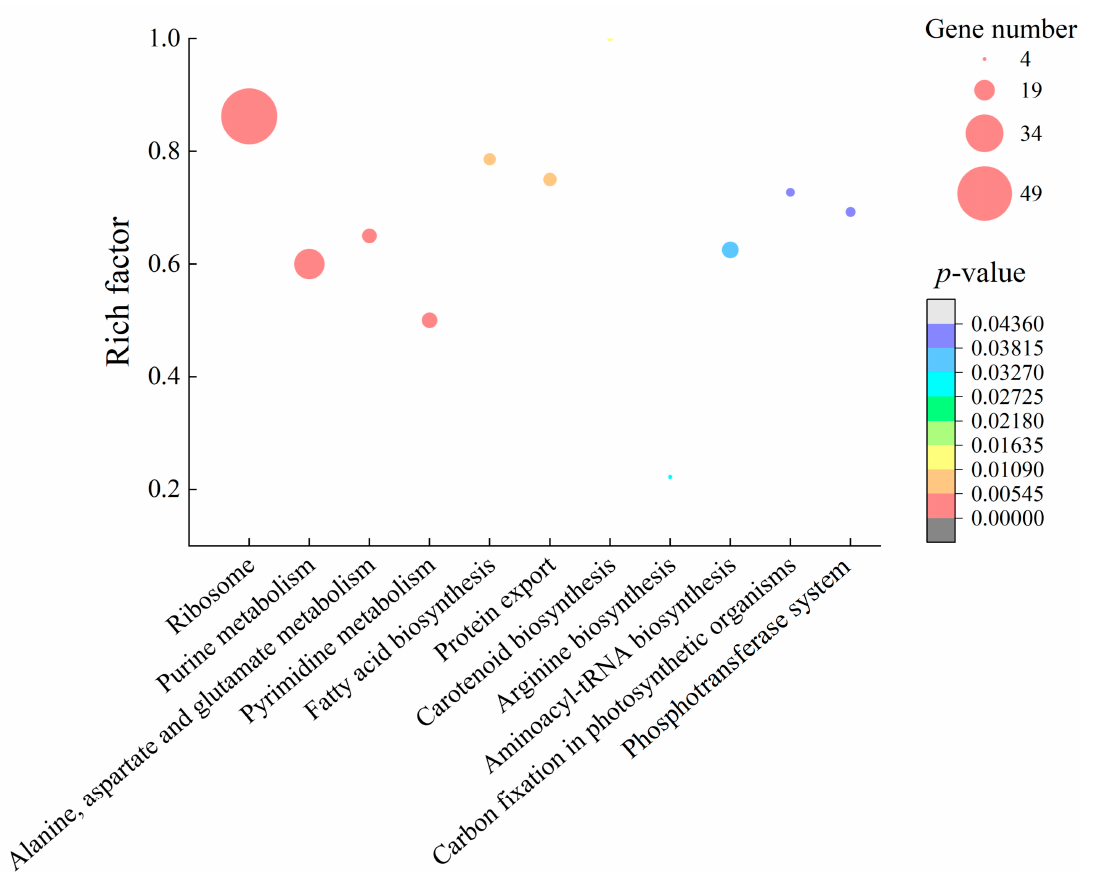
Figure 5. The significantly altered metabolic pathways in S. aureus ATCC8095 mediated by the GMPE.